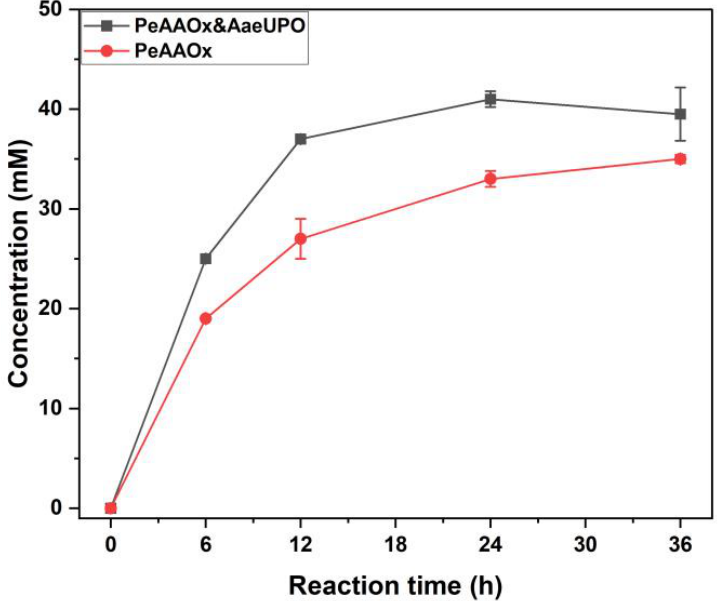
Figure 1. Comparison of catalytic effects of Pe AAOx catalysis alone (red) and Pe AAOx coupled with Aae UPO (black). (Reaction conditions: (1) [ Pe AAOx] = 32 µ M, [veratryl alcohol] = 50 mM (pre-dissolved in acetonitrile), 40 ◦ C, pH 7 and 500 rpm); (2) [ Pe AAOx] = 30 µ M, [ Aae UPO] = 2 µ M, [veratryl alcohol] = 50 mM (pre-dissolved in acetonitrile), 40 ◦ C, pH 7 and 500 rpm).